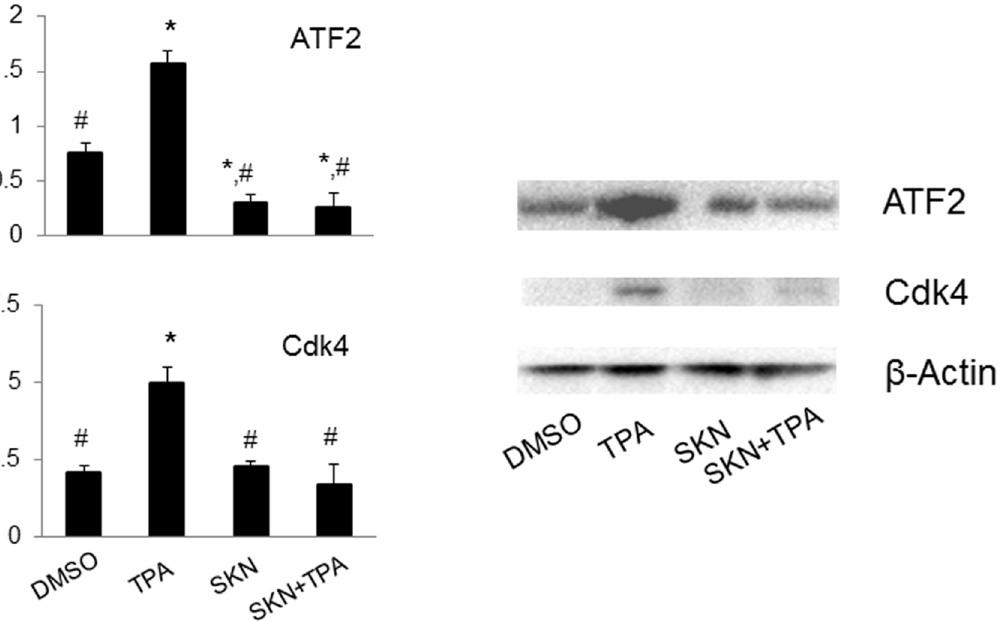
Fig 2. Detection of the expression levels of ATF2 and Cdk4 in mouse skin epidermal tissues at the end of the skin carcinogenesis study. Results were obtained from both the antibody microarray analysis (left panel) and Western blot analysis (right panel). Tissues from each individual mouse were pooled together and there were four repeats in each data group. DMSO, DMSO-treated group; TPA, DMBA/TPA-treated group; SKN, shikonin-treated group; SKN+TPA, shikonin plus DMBA/TPA-treated group. * , p < 0.05 compared with the DMSO Group; #, p < 0.05 compared with the TPA